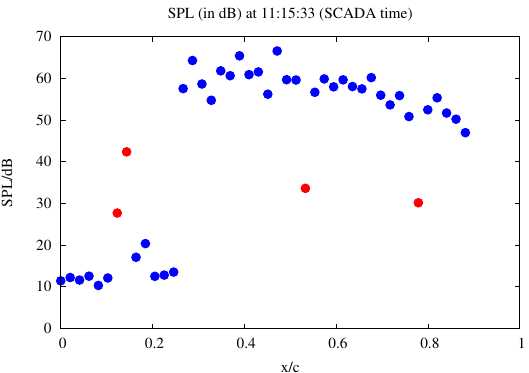
Figure 14. Thermographic flow visualization measurement at 11:15:32 (SCADA time). Left : Thermographic image. Right : x-y-plot of temperature.